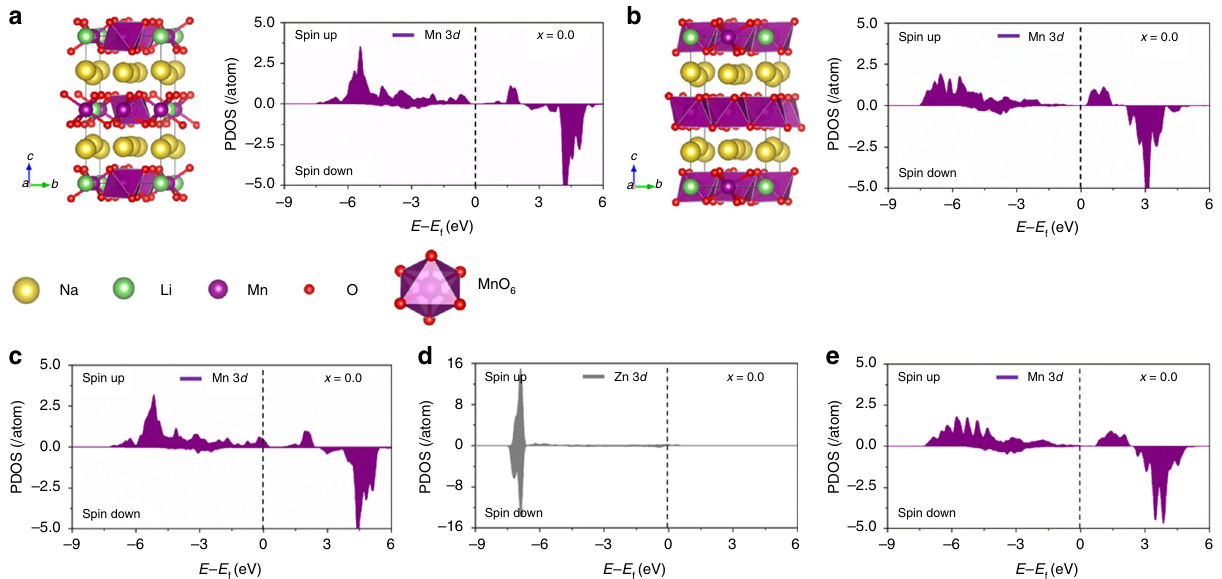
Fig. 1 Theoretical calculations regarding the effects of Zn doping in the fully sodiated Na[Li 0.25 Mn 0.75 ]O 2 . a Shows the Mn 3 + sites as purple octahedra in the relaxed crystal structure of Na[Li 0.25 Mn 0.75 ]O 2 together with its corresponding PDOS. Likewise, the Mn 4 + sites are shown as purple octahedra in b together with its corresponding PDOS. c Shows PDOS of the Mn 3 + sites in the Zn-doped Na[Li 0.25 Mn 0.75 ]O 2 . Likewise, PDOSs of the Zn 2 + and the Mn 4 + sites in the Zn-doped Na[Li 0.25 Mn 0.75 ]O 2 are shown in d , e , x = 0.63 and at x = 0.75 are present for Na[Li 0.25 Mn 0.75 ]O 2 and is indicative of phase separation when desodiated to this extent. By